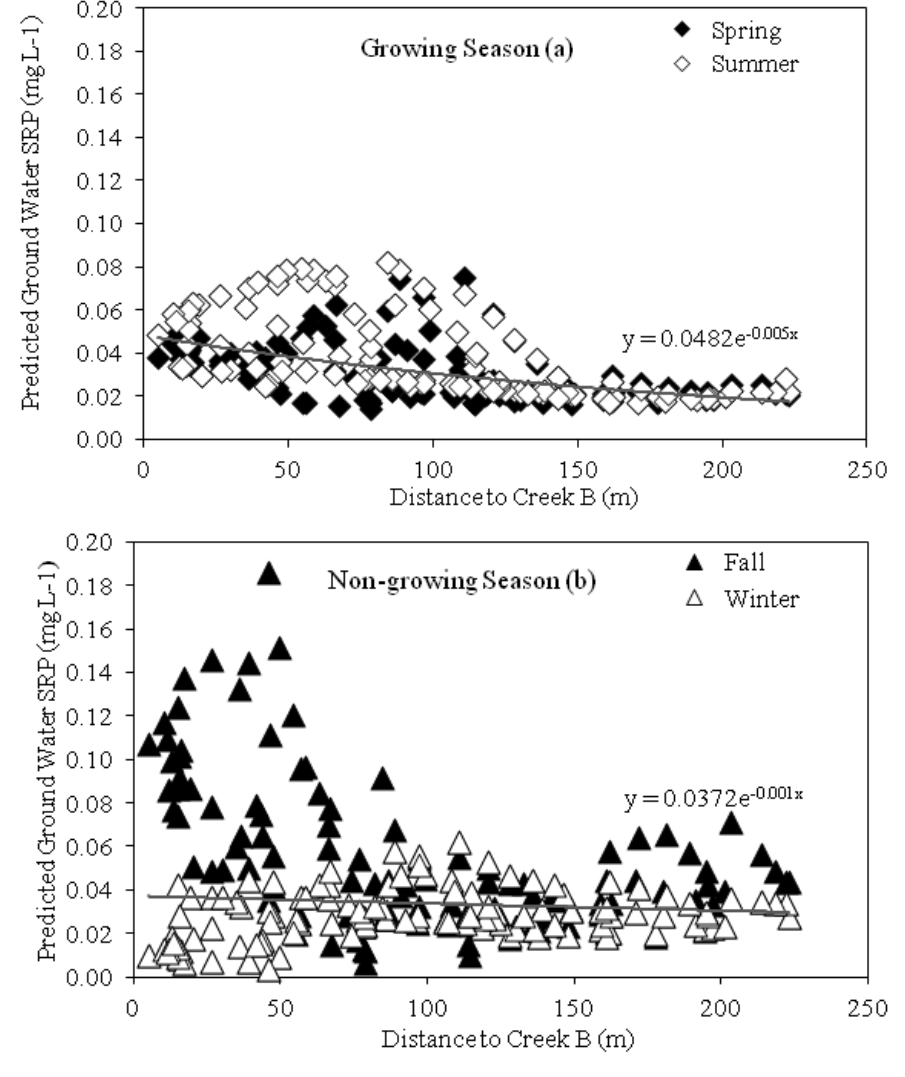
Figure 6. Predicted groundwater SRP concentration for each 10-m cell size draining into Creek B based on the predicted groundwater SRP concentration map for ( a ) growing- and ( b ) non-growing seasons and corresponding flow distance to Creek B obtained from the MODFLOW